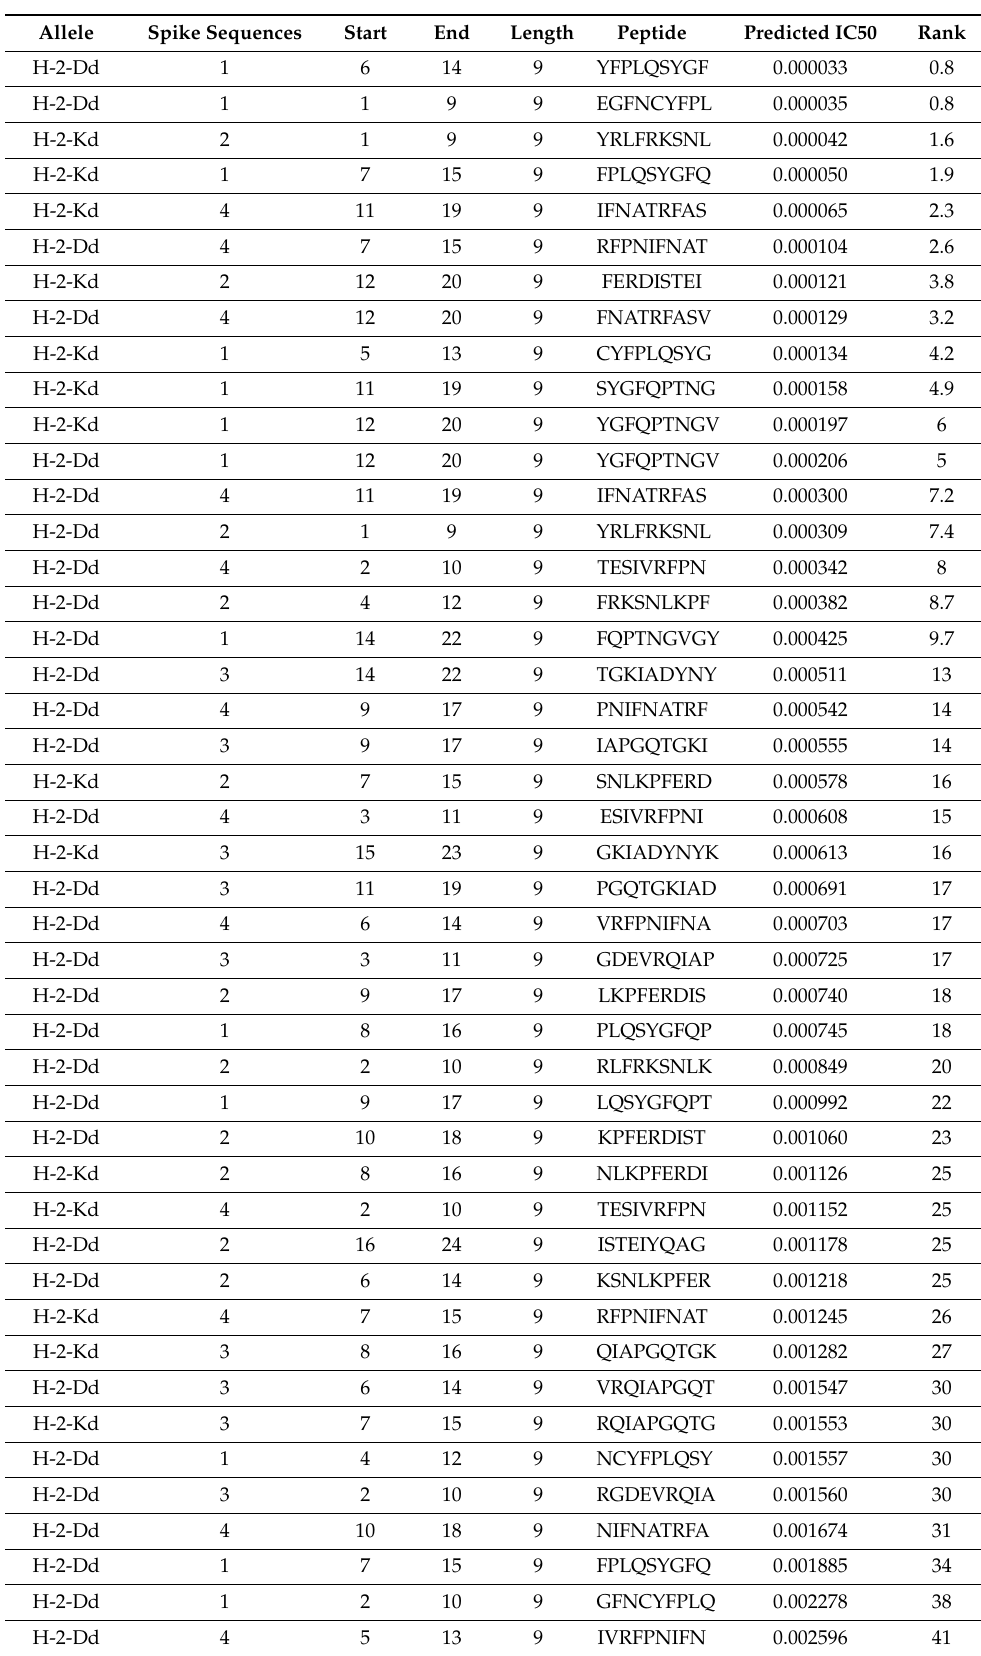
Table 5. BALB/c MHC class I epitopes in predicted